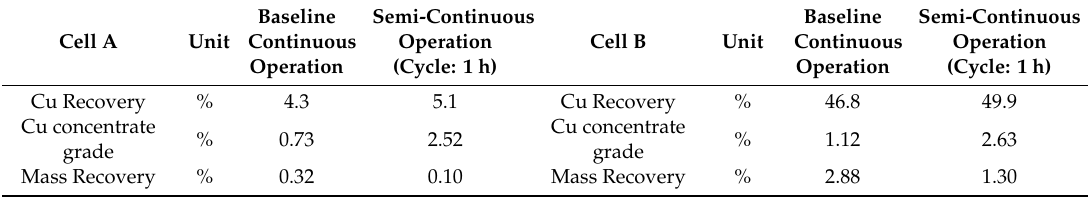
Table 2. Comparison of simulation results for continuous and semi-continuous operations. Last flotation